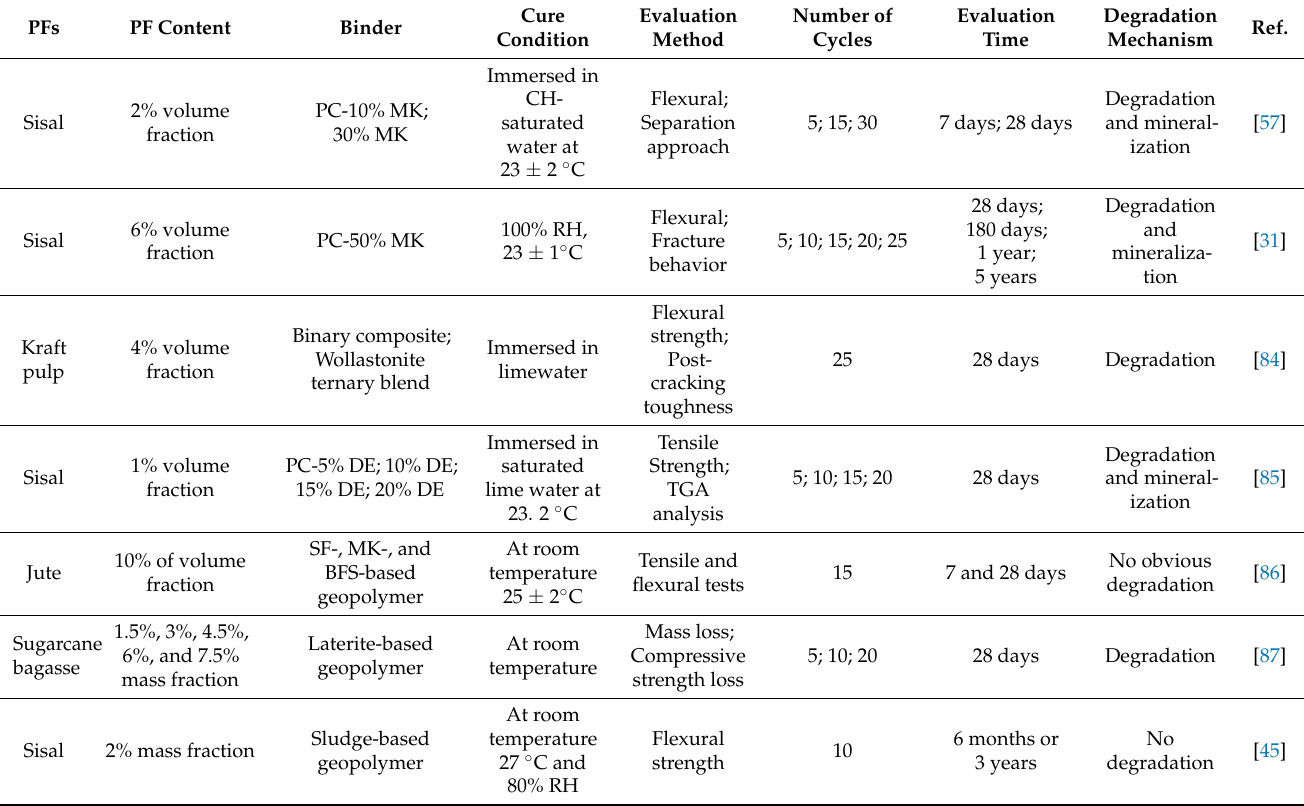
Table 3. Research on PF reinforcements under wetting and drying cycles and main parameters.